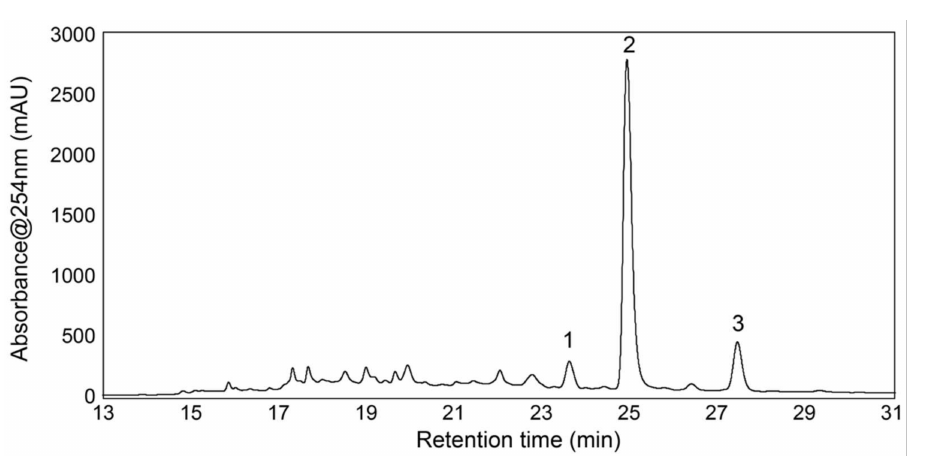
Figure 5. HPLC chromatogram at 254 nm of the 40% acetonitrile fraction. The material eluted with peaks one, two, and three were isolated (and denoted compounds 1 – 3 ) and tested for synergistic effects with SN-38 on HT29 SN38 cells, as